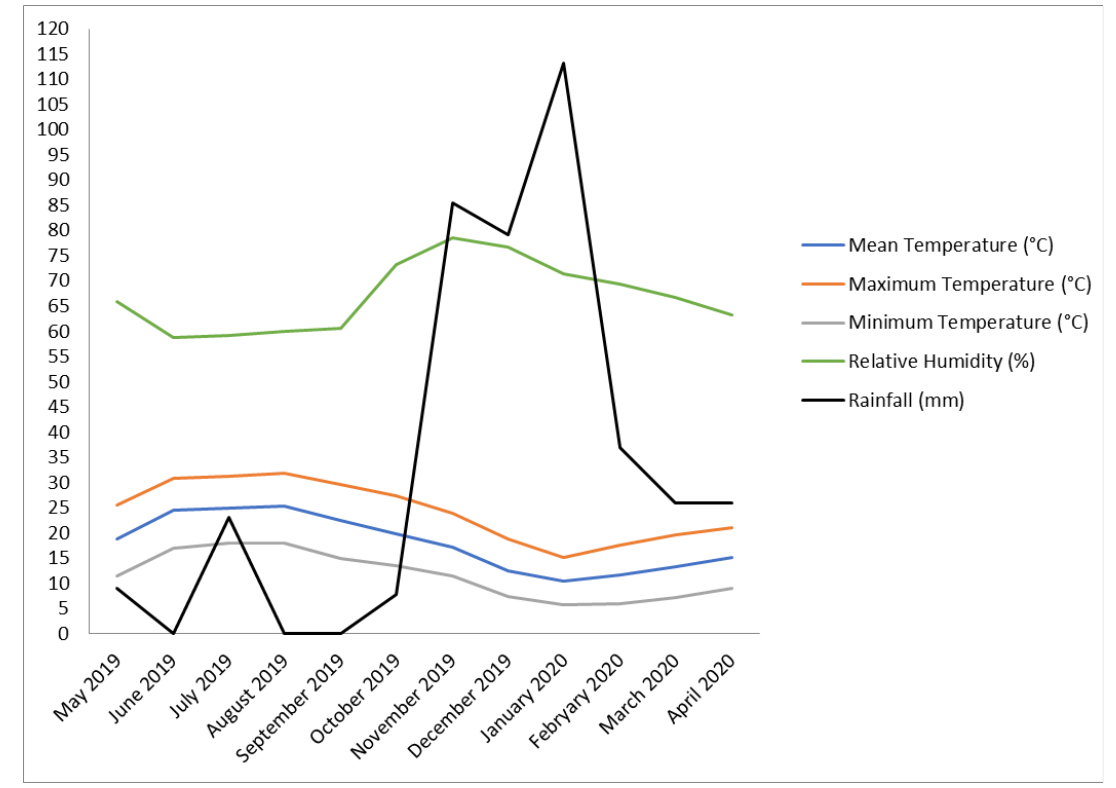
Figure 1. Meteorological data in 2019 and 2020.